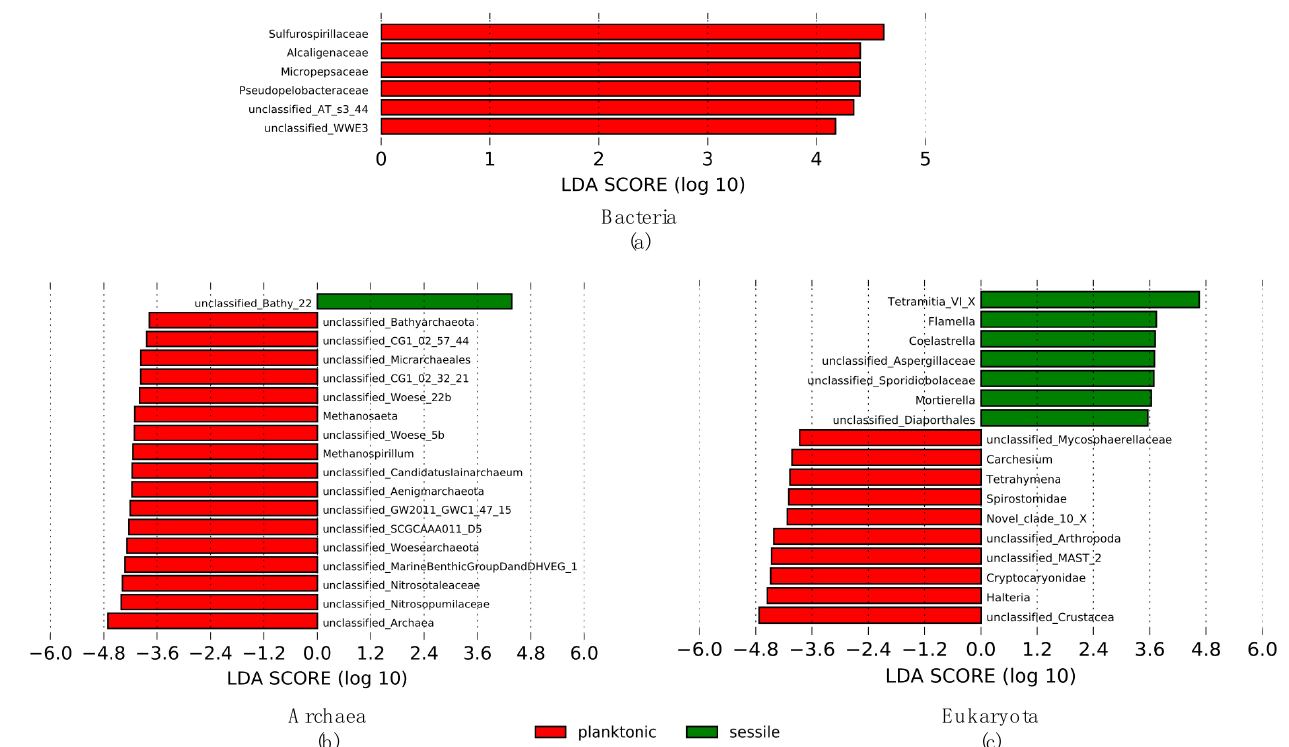
Figure 4. Discriminative features of bacterial ( a ), archaeal ( b ) and eukaryotal ( c ) taxa between plank- tonic and sessile communities at the genus level, using LEfSe analysis (log LDA threshold > 2, p < 0.05).